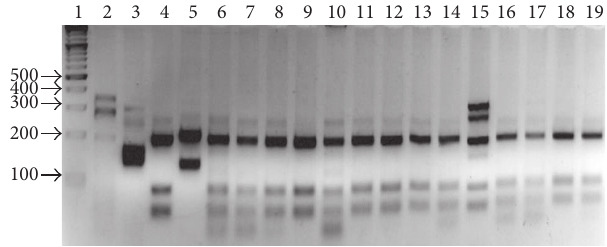
Figure 2: ITS1 PCR-RFPLC of Mexican Leishmania cultures. Lane 1: MWMX174 Hae III ; lanes 2 to 19: Mexican cultures of Leishmania.